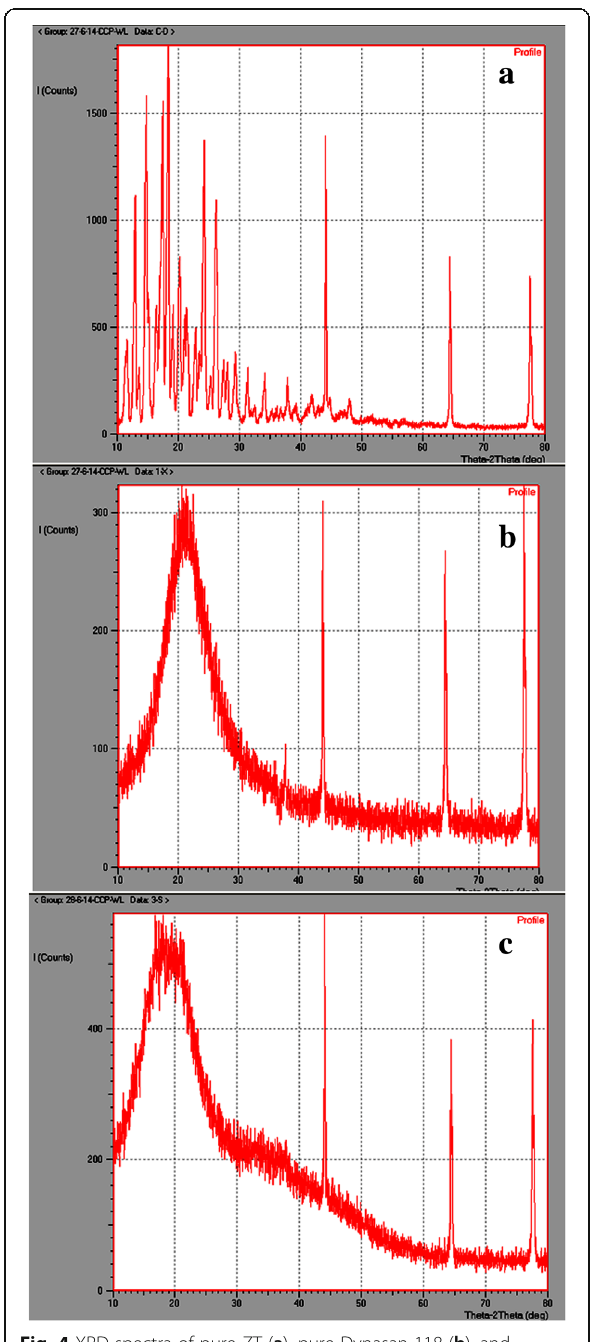
Fig. 4 XRD spectra of pure ZT ( a ), pure Dynasan-118 ( b ), and lyophilized optimized ZT-SLN (F1) formulation ( c